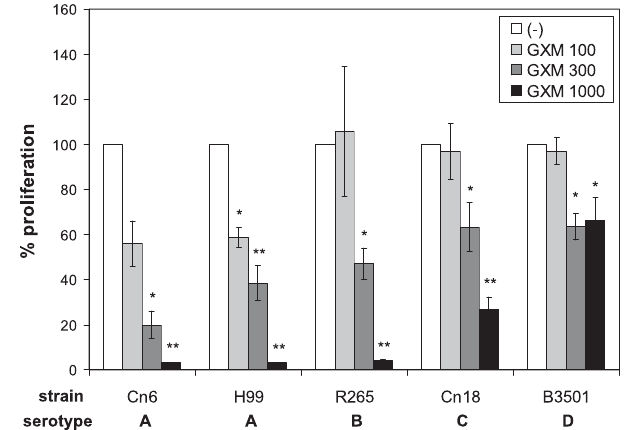
Figure 7. GXM from Four Cryptococcal Serotypes Inhibits Proliferation of Human PBMCs PBMCs were activated with tetanus toxoid (TT) in the presence or absence of GXM (100, 300, or 1,000 l g/ml) isolated from serotype A strain Cn6, serotype A strain H99, serotype B strain R265, serotype C strain Cn18, or serotype D strain B3501. Proliferation was measured by [ 3 H]thymidine incorporation 6 d later. Data are expressed as the percent proliferation compared with TT alone ( (cid:1) ) (set at 100%) and are expressed as the mean 6 SEM of four donors (or two donors for strain Cn6 GXM) assayed in triplicate. The mean CPM for TT in the absence of GXM was 63,550. * p (cid:2) 0.005; ** p , 0.0001.